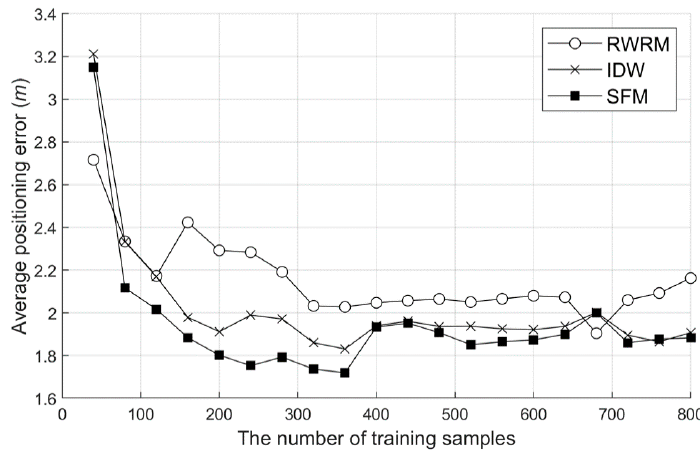
Figure 10. Positioning average errors according to the interpolation method. RWRM: raw WRM and IDW: inverse distance weighting.